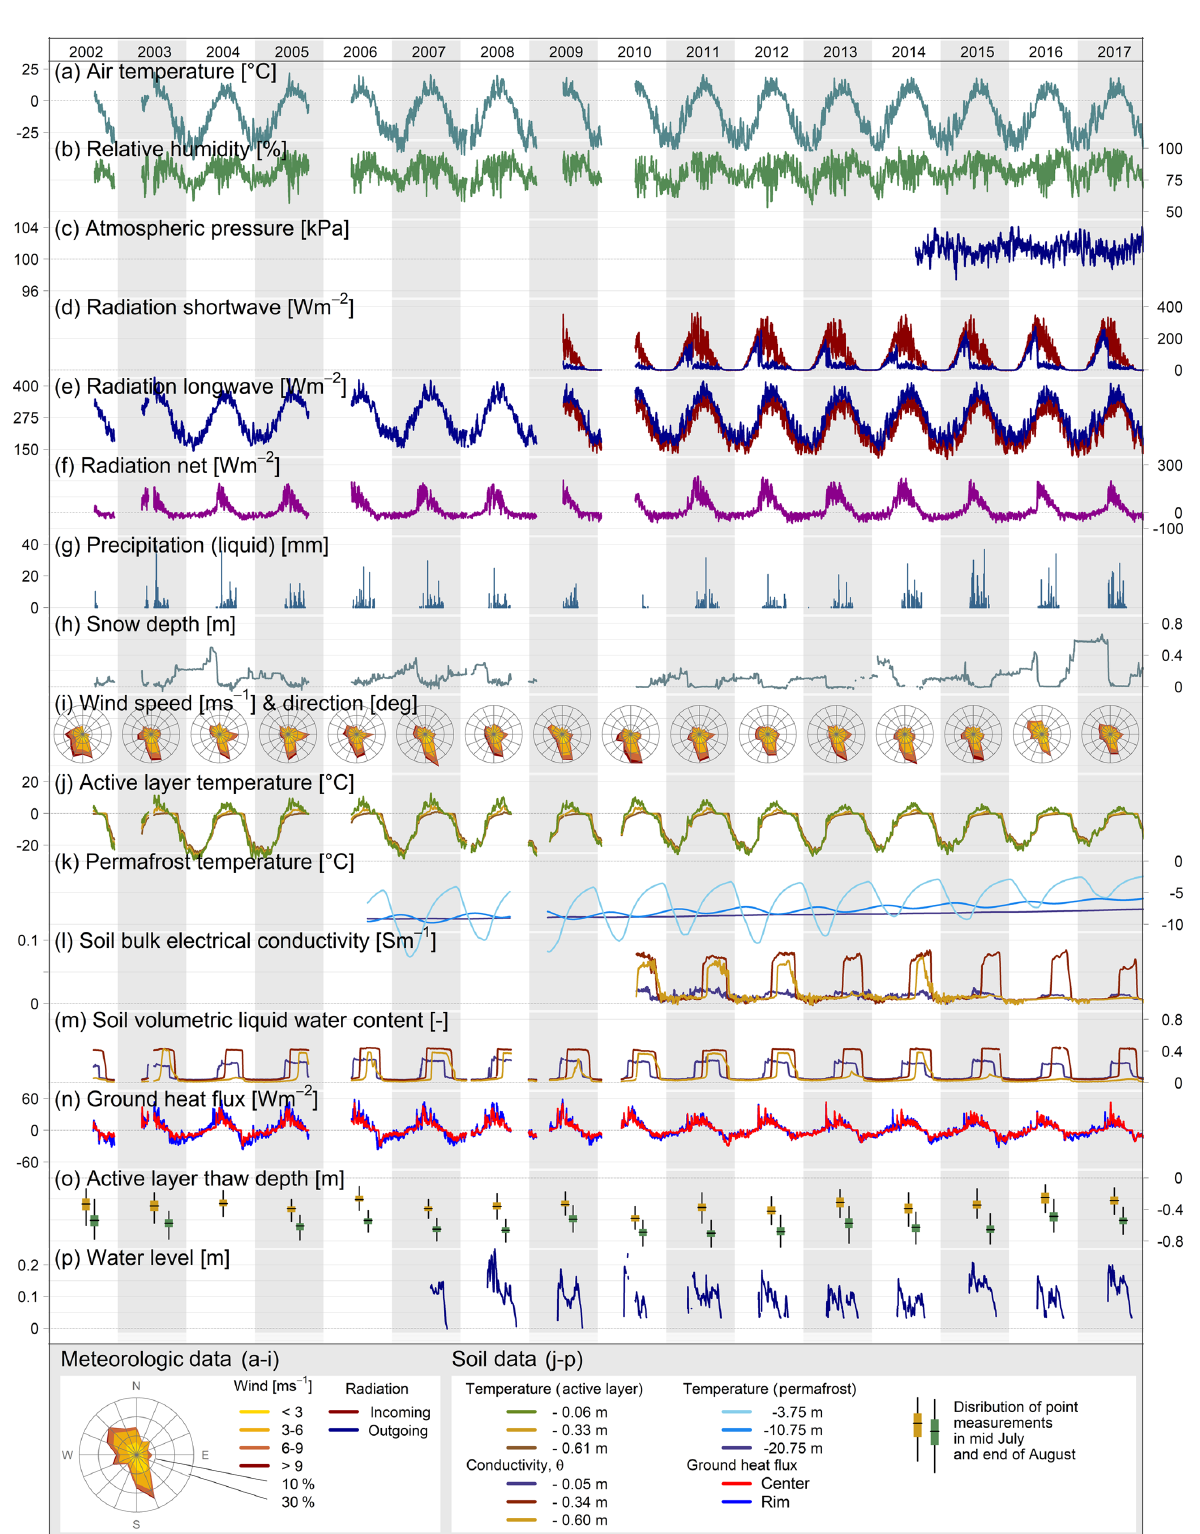
Figure 2. Time series (daily mean values) of Samoylov data presented in this paper: (a–i) meteorological data and (j–p) soil data. Seasonal average active-layer thaw depth (o) was measured at the 150 data points on the Samoylov CALM grid. Further details on the sensors and periods of operation are given in Table